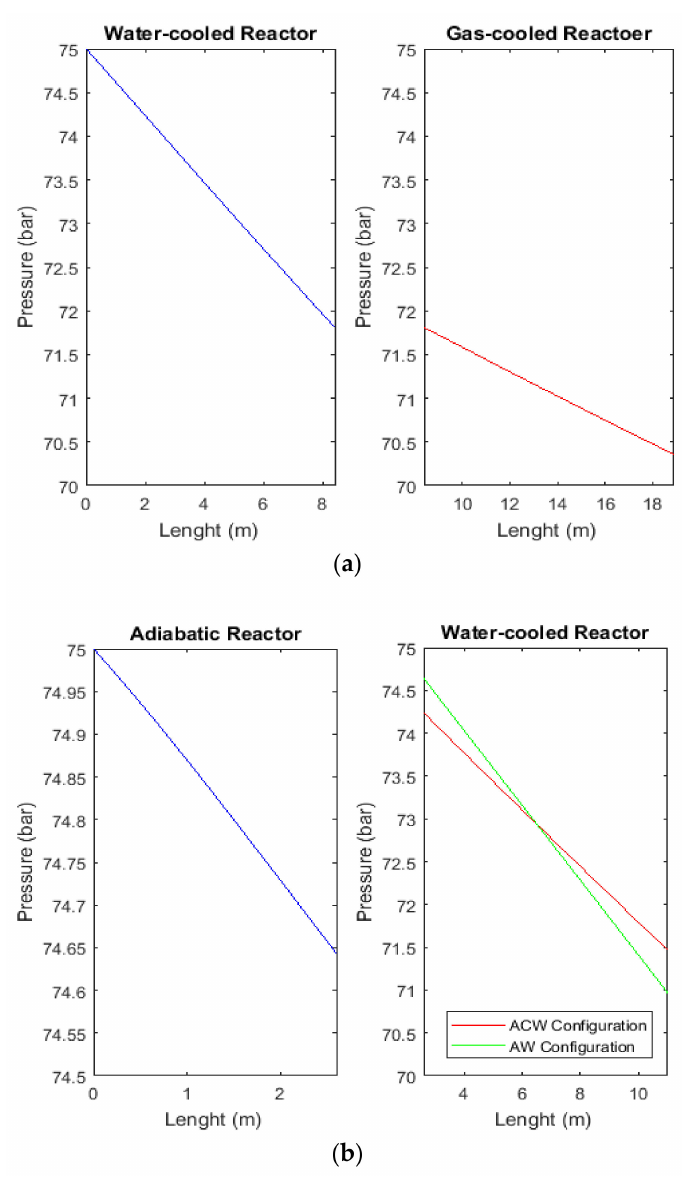
Figure 4. Pressure profile along reactors in ( a ) CR configuration; and ( b ) AW and ACW